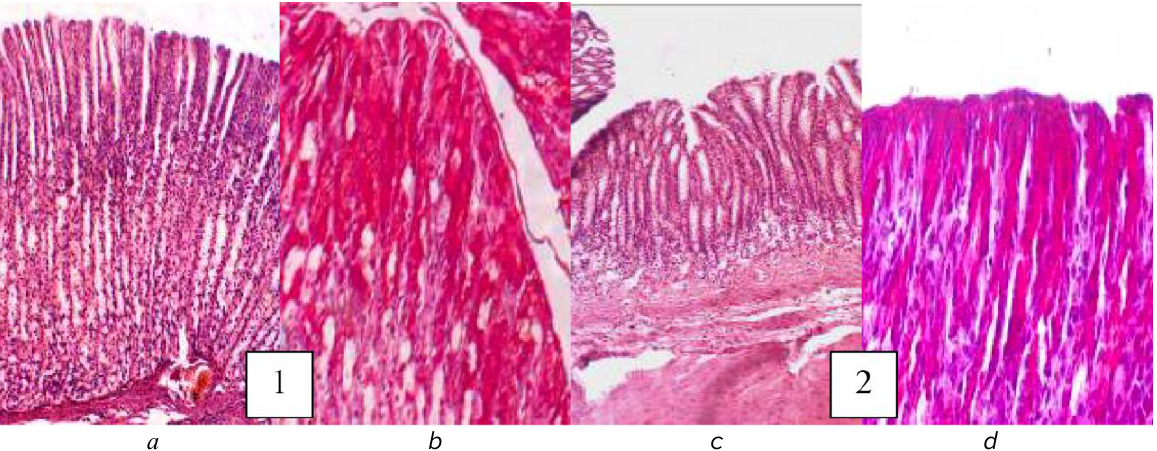
Fig. 2. The prepyloric part of the stomach of intact rats 1: a – the state of the cellular elements in the intermediary glands corresponds to the normal (haematoxylin-eosin, ×200), b – sufficient PAS-positive reaction in secretory cells. The pyloric portion of the stomach of intact rats 2: c – integumentary-epithelium, cells of the pyloric glands of the mu- cous membrane unchanged; d – expressive PAS-positive reaction in secretory cells (PAS-reaction, ×250, ×400) In the pyloric stomach surface epithelium is high- er, the gastric pits are deeper and broader. Pyloric glands are located quite loose, connective tissue layer between them more expressive. The glandular tube is lined by a tions (Fig. 2).